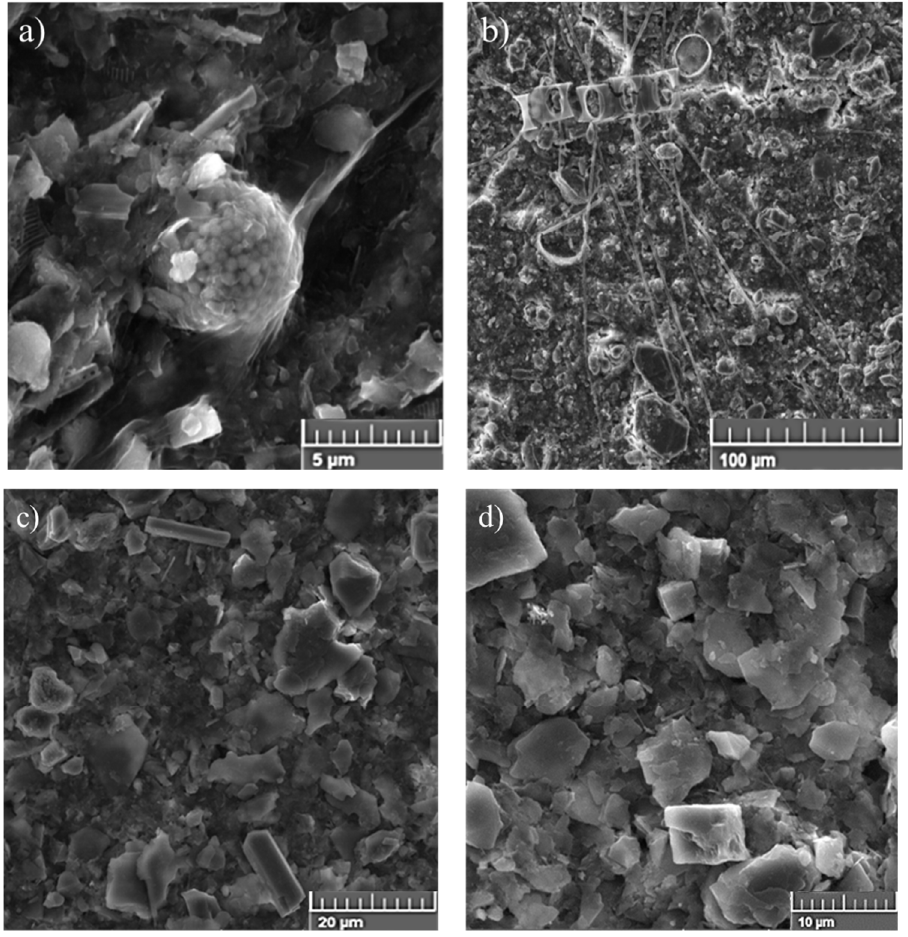
Figure 5. The composition of suspended particulate matter at station 5945: ( a )—layer 50 m, ( b )—layer 160 m; station 5981 ( c )—20 m, ( d )—90